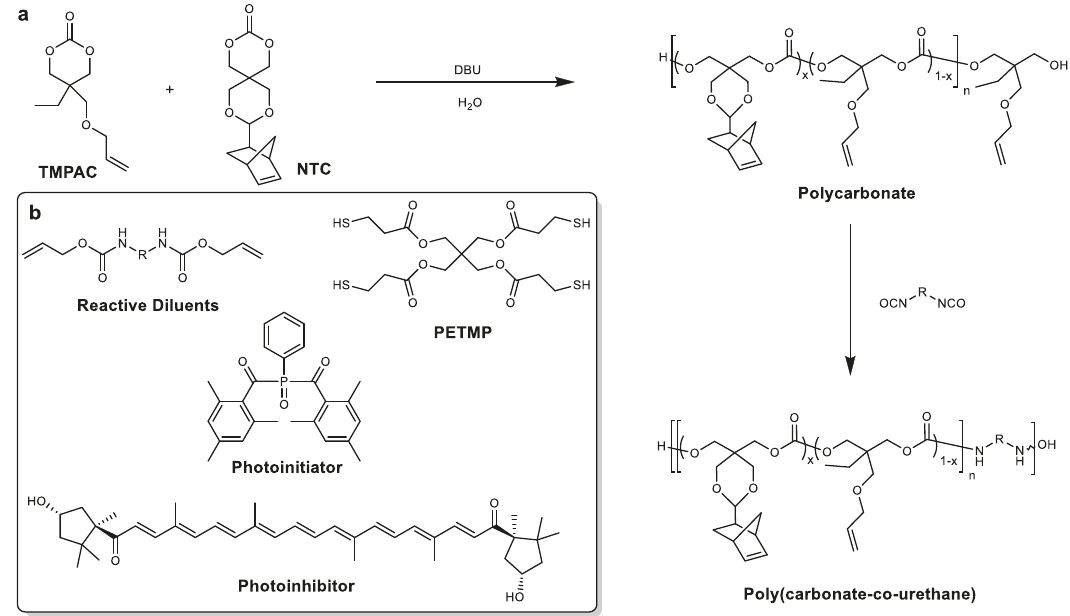
Fig. 1 General reaction scheme for producing aliphatic polycarbonate-derived photopolymer resins. Aliphatic polycarbonates were synthesized using organobase-catalyzed ROP of cyclic carbonate monomers, producing low viscosity prepolymer polycarbonates to which were added allyl- and norbornene- functionalized crosslinkers and multifunctional thiols ( a ) and combined with reactive diluents (R = hexamethylene and isophorone), a photoinitiator and photoinhibitor to produce a liquid resin ( b ).